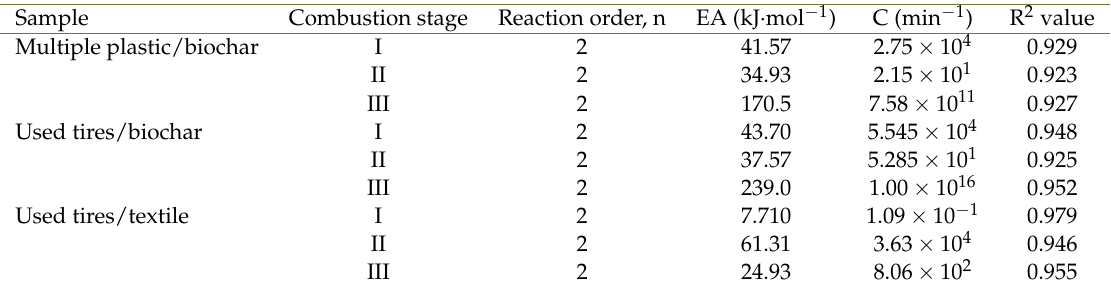
Table 3. Combustion kinetic parameter of the combination of biomass solid